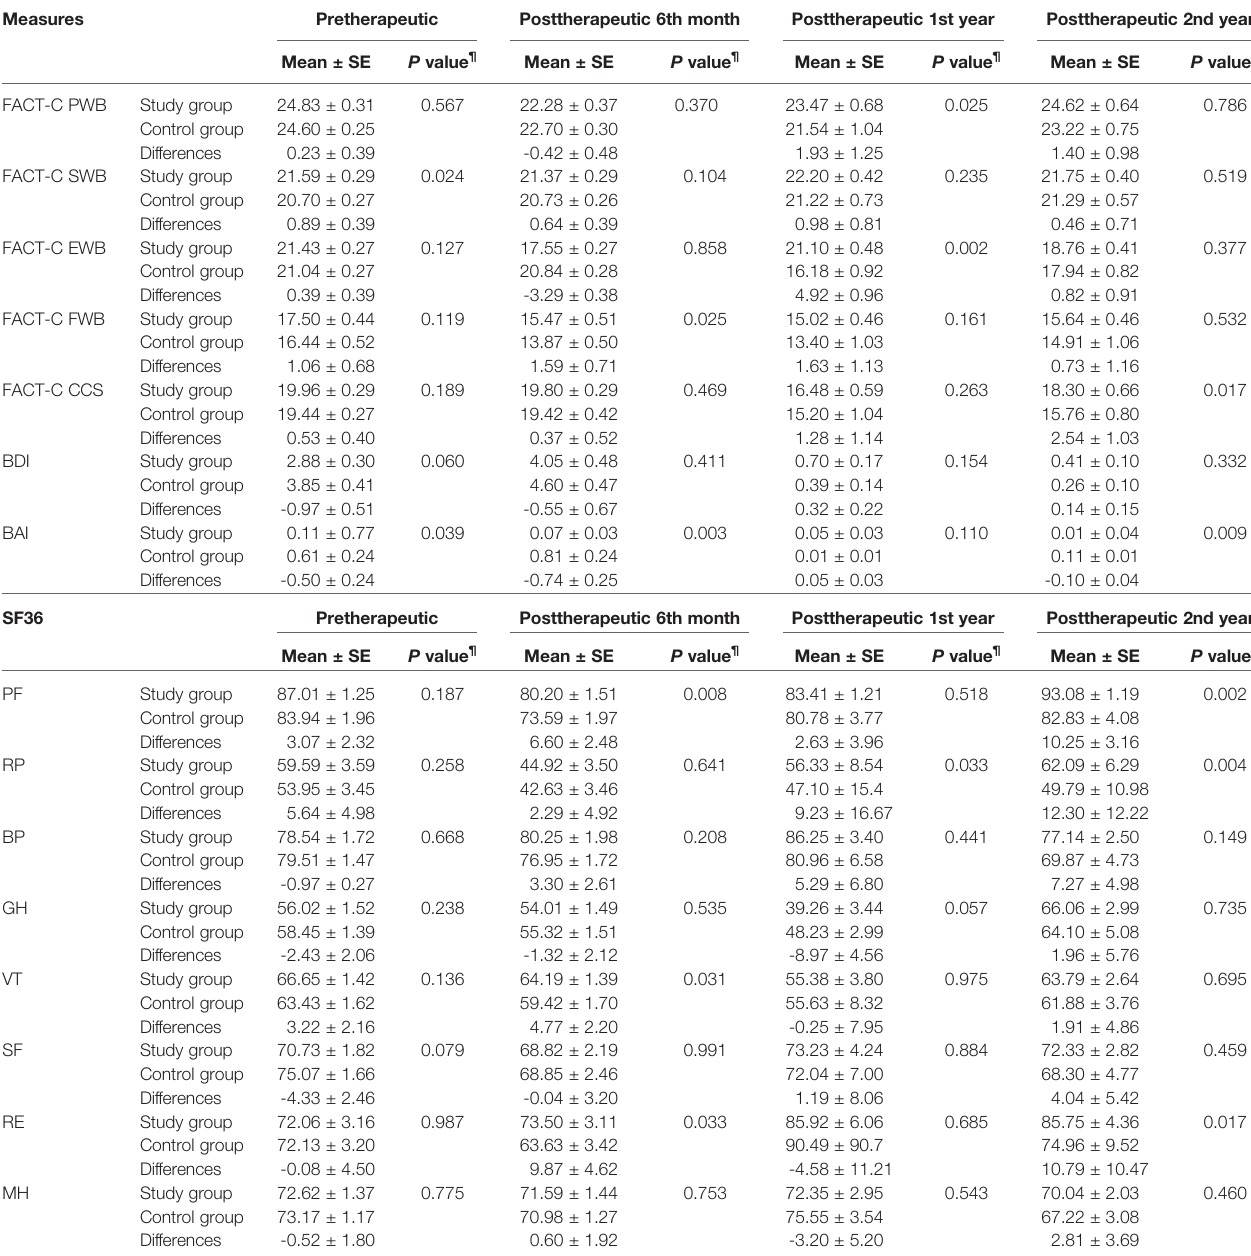
TABLE 4 | Generalized estimating equations (GEE) model with difference-in-difference (DID) method was employed to evaluate differences in the FACT-C, BDI, BAI, and SF-36 between the two groups in patients with metastatic colorectal cancer at different time points ( N =196). Measures